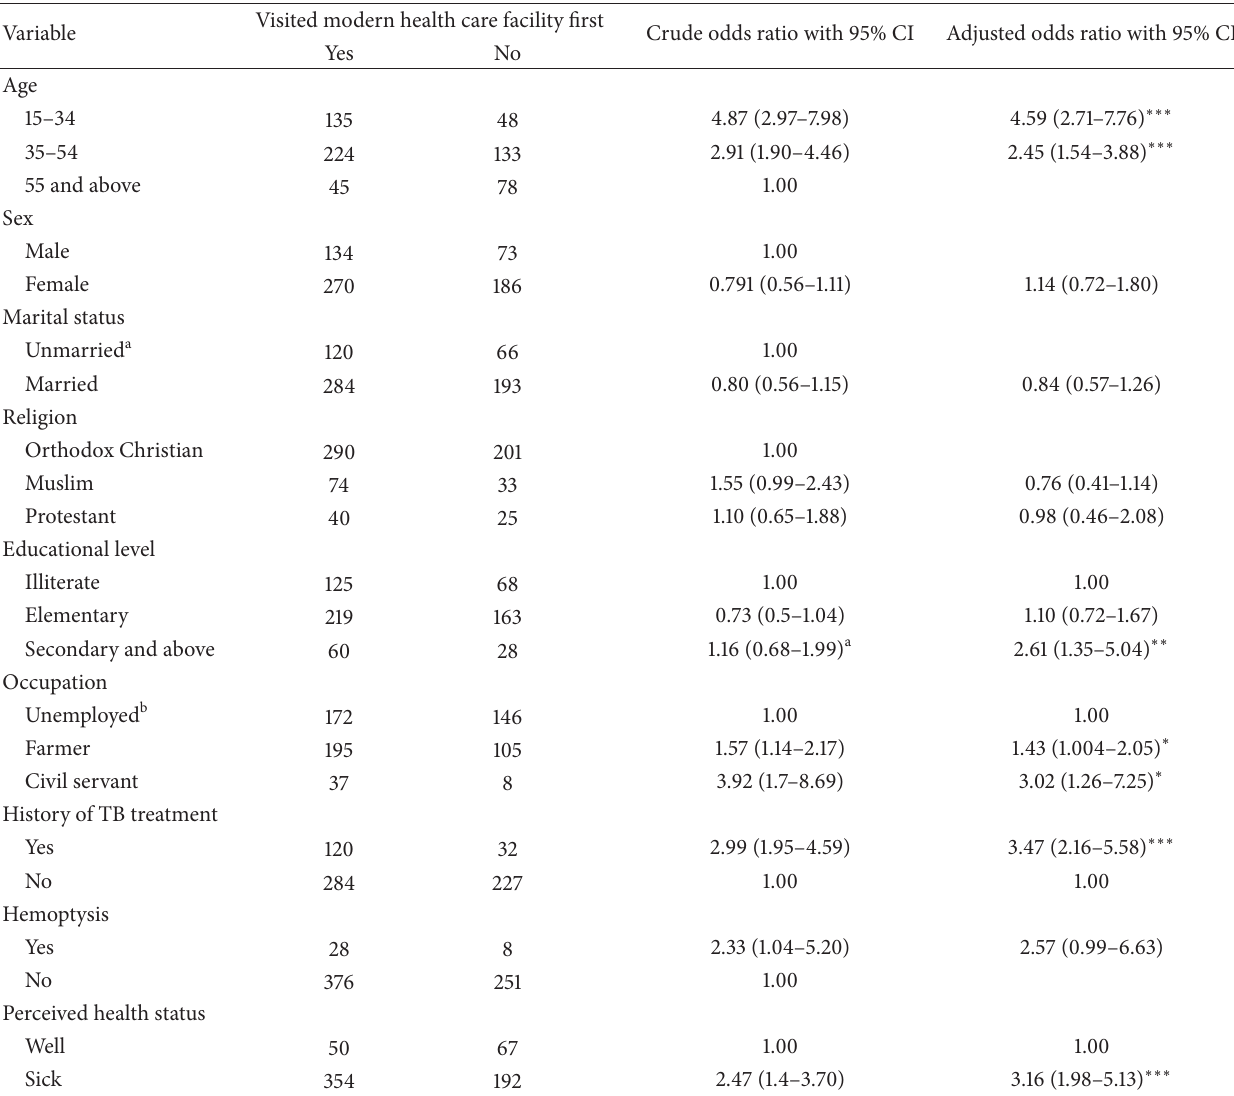
tuberculosis suspects in Lay Armachiho district, Northwest Ethiopia,